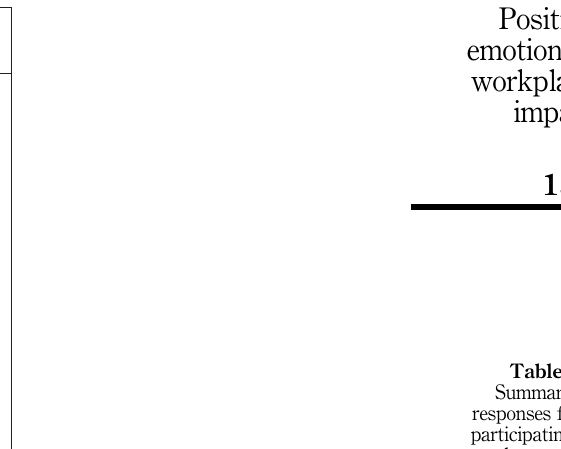
Table III. Summary